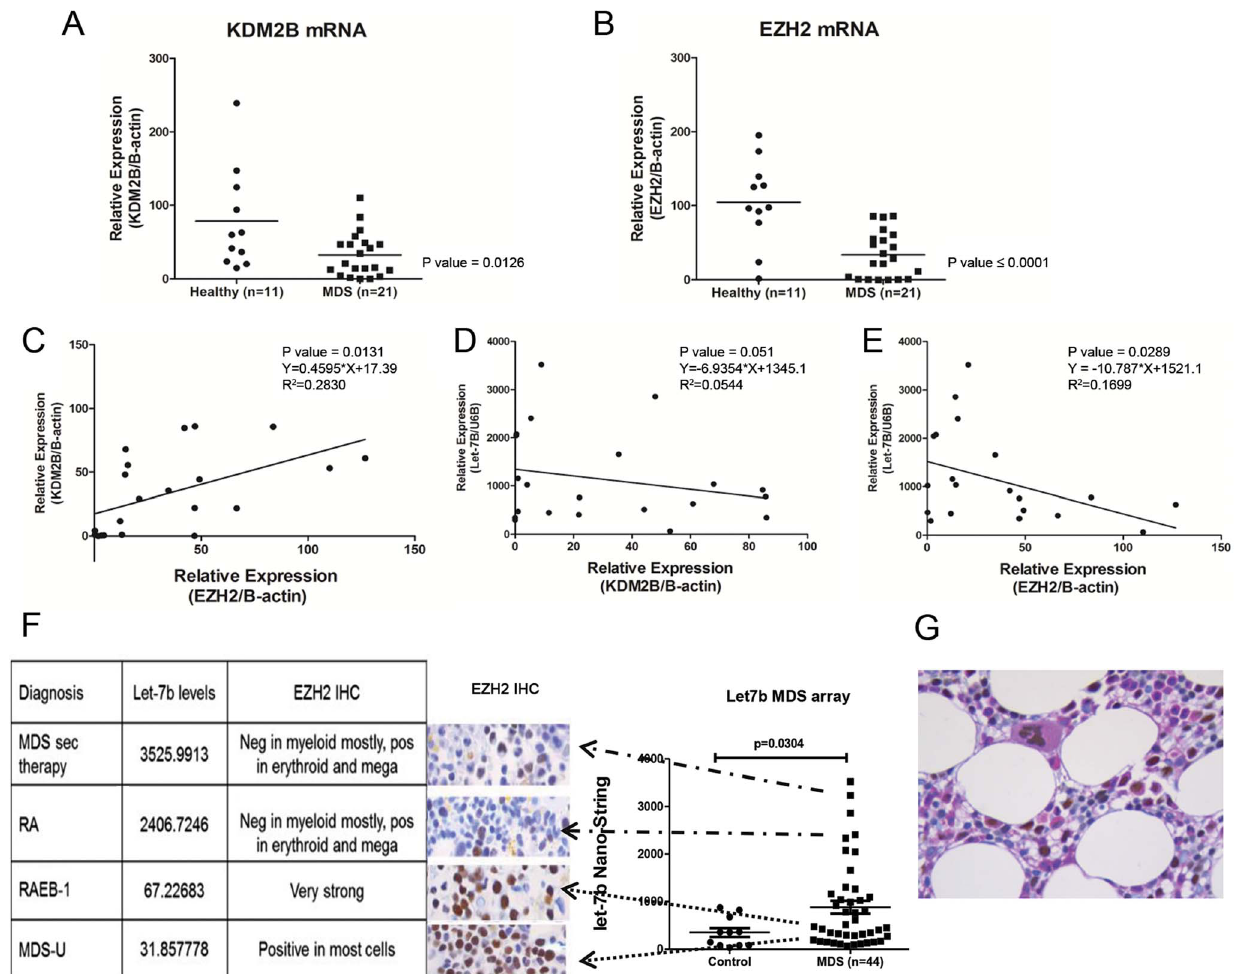
Figure 2. KDM2B, and EZH2 expression in myeloid cell lines and primary MDS marrow cells. Expression of KDM2B, A ) and EZH2, B ) in marrow cells from MDS patients (n=21) and healthy controls (n=11) (p=0.0126 and , 0.001, respectively, Student t-test). C ) Direct correlation of KDM2B and EZH2 (p=0.0131, R 2 =0.2830, 95%CI 0.1300–0.7837), D ) Inverse correlation of let-7b and KDM2B, E ) Inverse correlation of let-7b and EZH2. F ) Immunohistochemistry (IHC) for EZH2 on marrow sections from 6 patients with MDS and linkage to Let-7b levels as determined by miRNA microarray. BM CD34 + from MDS patients expressing higher levels of let-7b expressed lower levels of EZH2, and vice versa. G ) EZH2 immunohistochemistry on a normal marrow with Periodic Acid-Schiff stain as the counter stain was used for the purpose of lineage differentiation. The large cells with brown nuclear staining are a morphologically normal megakaryocytes, positive for EZH2. Of the remaining cells, eosinophilic cells of myeloid lineage and show low level variable reactivity for EZH2, while the remaining erythroid cells show dim to moderate reactivity for